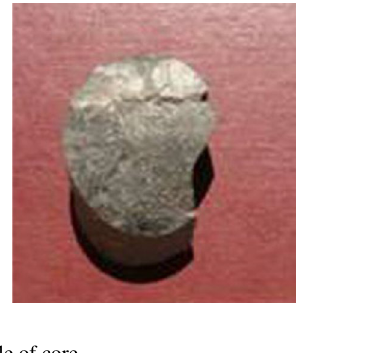
Fig. 2 The sample of core